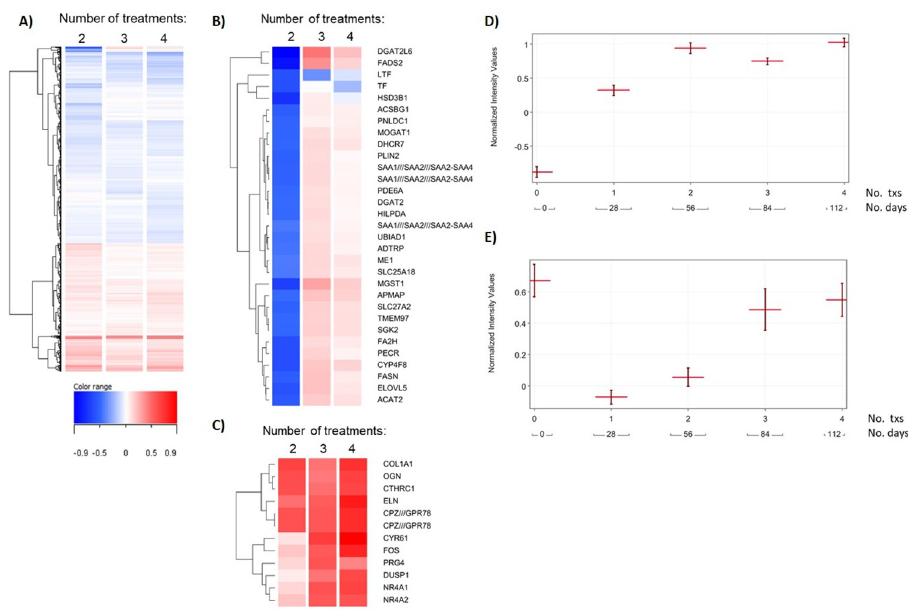
Fig 5. Effects of multiple laser resurfacing treatments over time on gene expression. A) Dendrogram displaying hierarchical clustering of genes by average log 2 fold change that were significantly changed at any multiple-treatment sites compared to the single-treatment site (n = 5,795 total). B-C) Dendrograms of select gene clusters differentially regulated from 2–4 laser resurfacing treatments ( B ) or continuously upregulated with increasing number of treatments ( C ). D-E) Profile plots showing normalized expression values ( ± SEM) of COL1A1 ( D ) and NR4A1 ( E ) across the different number of treatments over time.